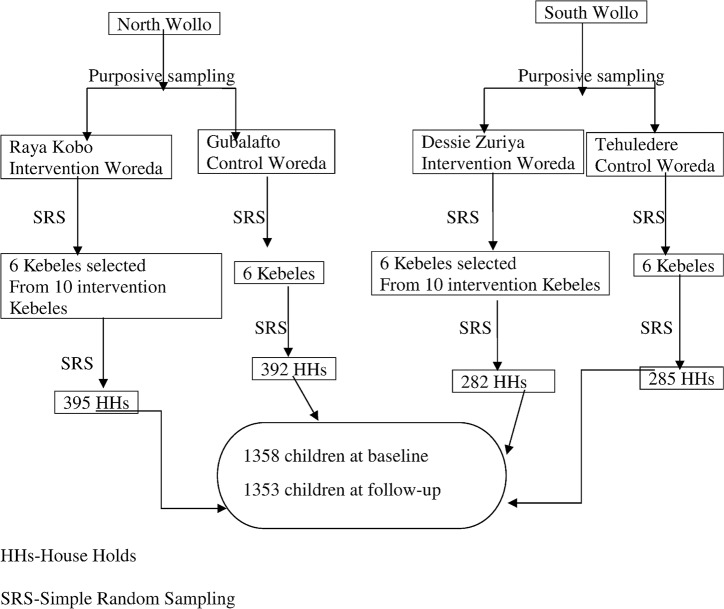
Sampling procedure for selecting the study units and participants.